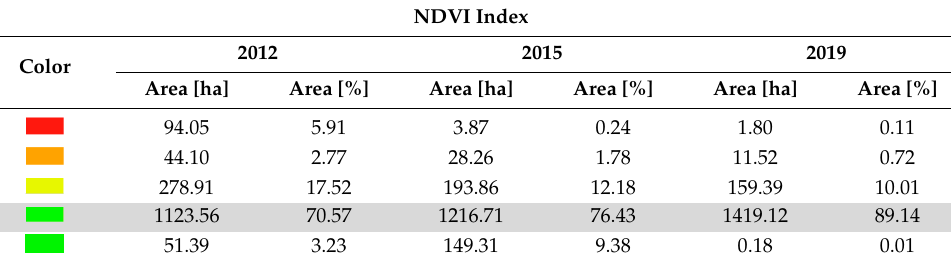
Grey background presents the largest increase in values.